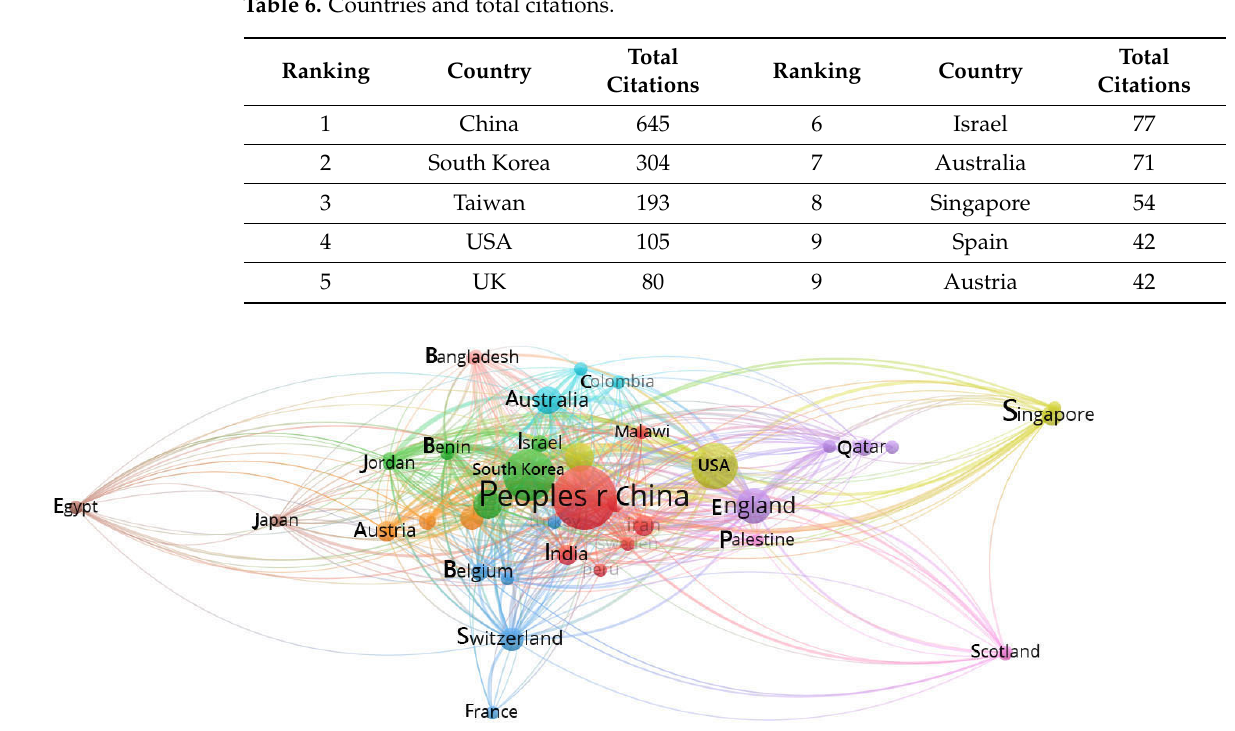
Table 6. Countries and total citations.